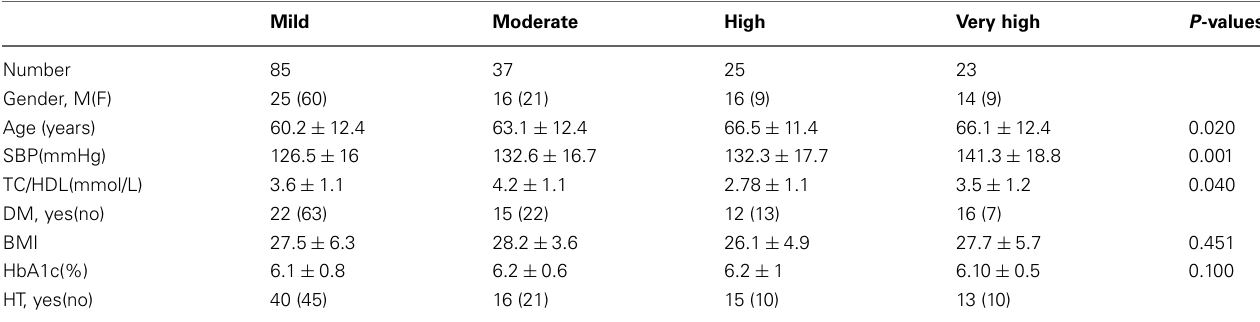
Table 1 | Study population framingham CVD risk parameters and demographics. Mild